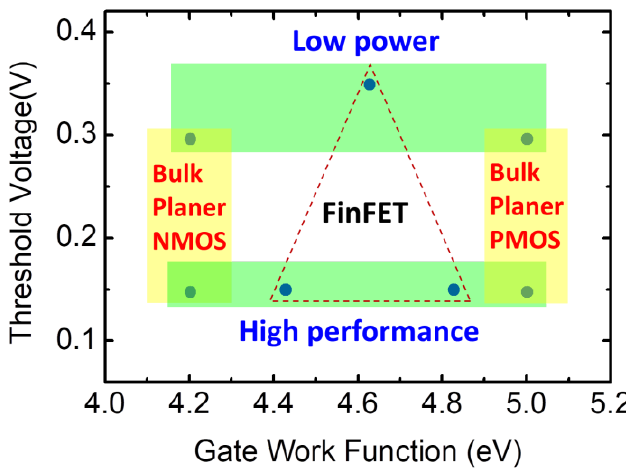
Figure 9. The relation between the threshold voltage and the work function of the metal gate for different devices.